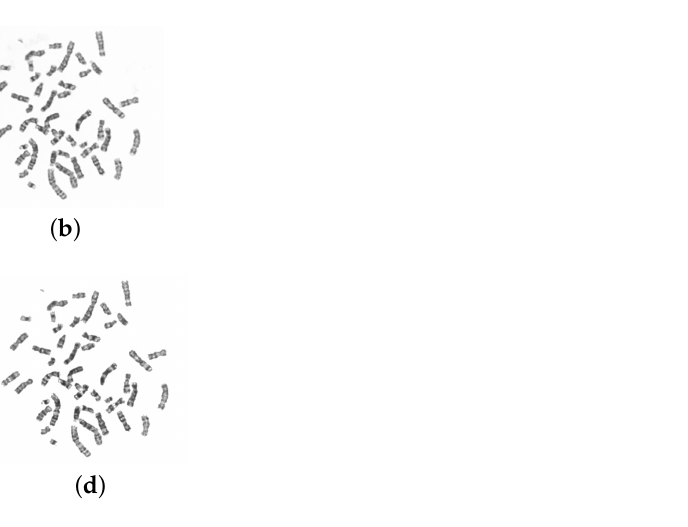
Figure 5. Schematic diagram of image enhancement processing results. ( a ) Original; ( b ) grayscale; ( c ) contrast stretched; ( d ) proposed method.